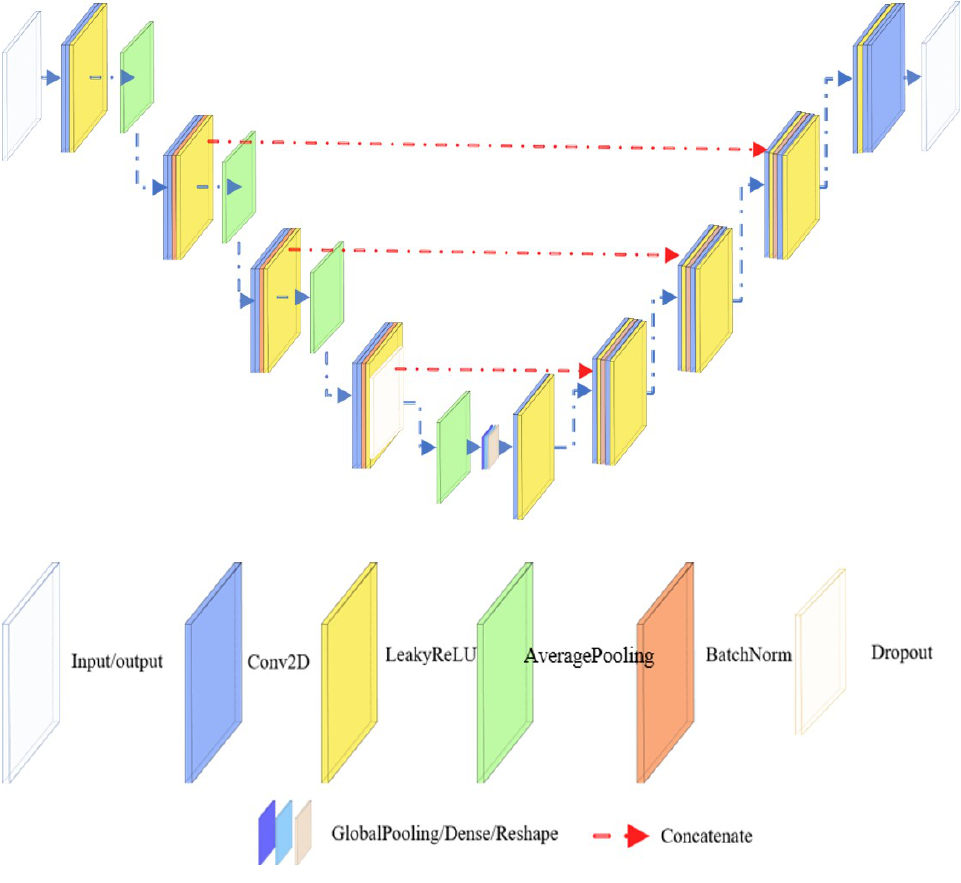
Figure 1. Generator